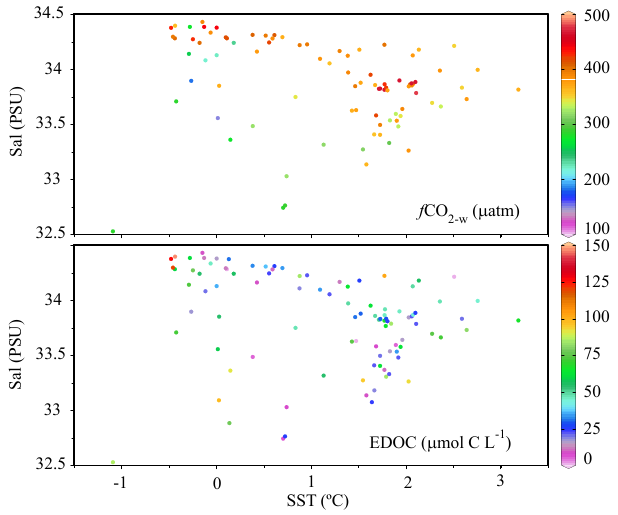
Figure 4. Temperature–salinity diagram color-coded for f CO 2 − w and EDOC for all three cruises combined.